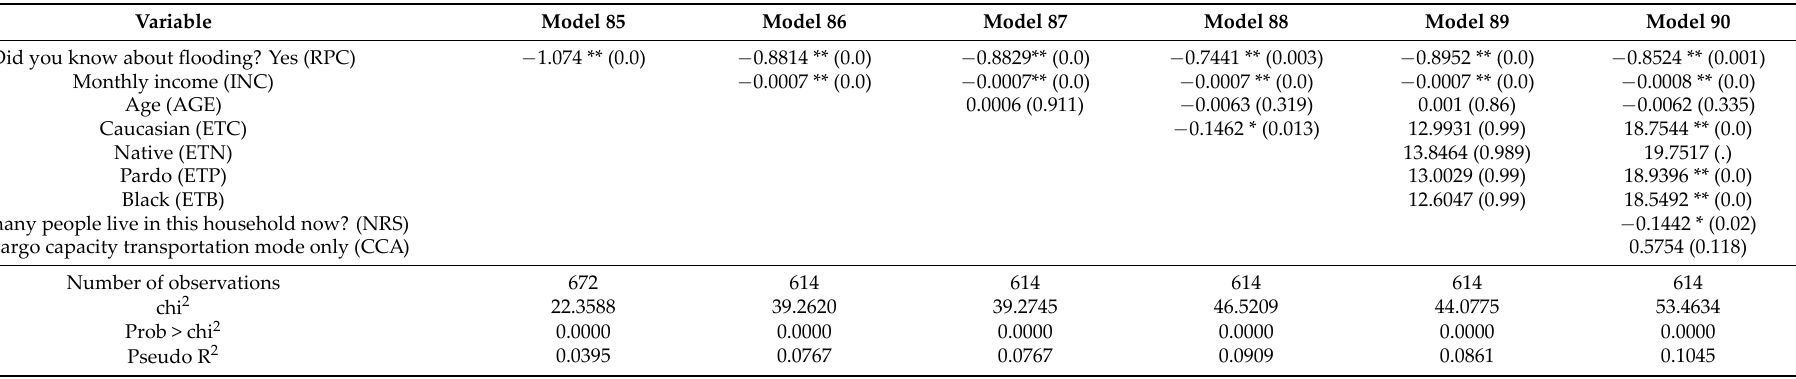
Table 5. Logit regression analysis for set (b): residents inside the flood protection system for risk‑response alternative RP1: evacuate the area. Acronyms follow the definitions in Table 1.